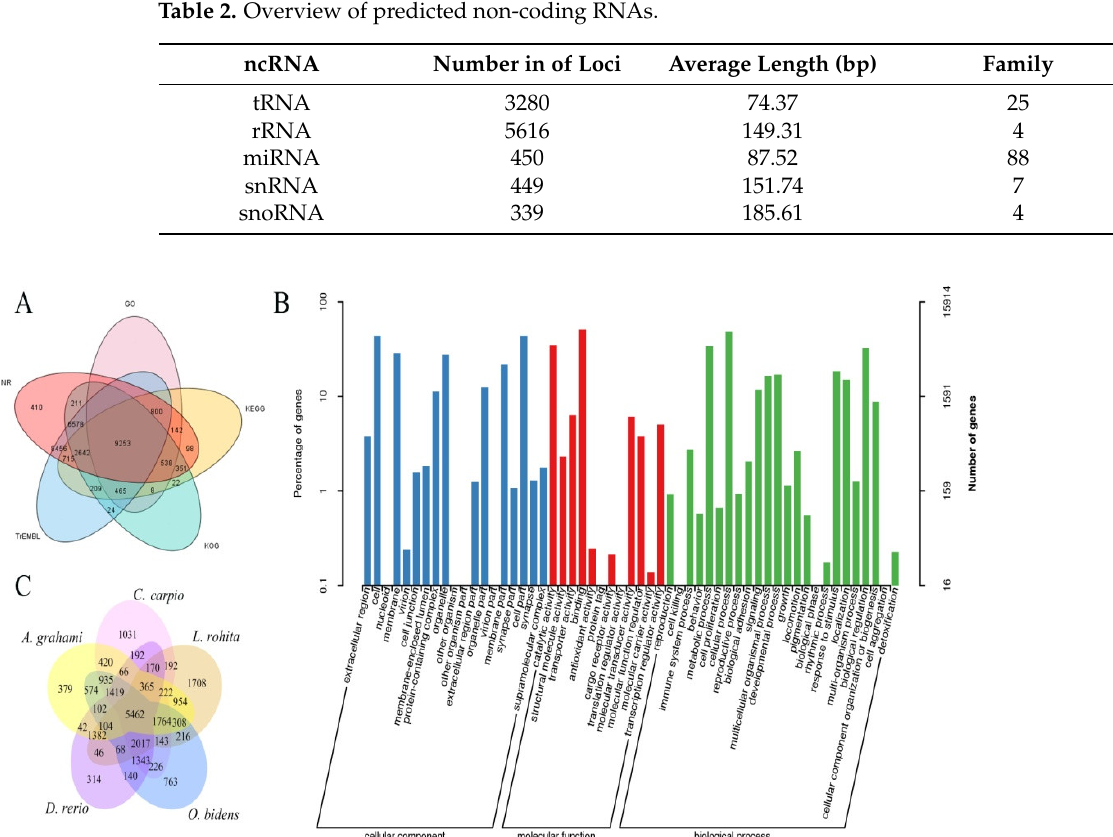
Figure 2. Gene annotation and function of male O. bidens ’ genome. ( A ) Different database-annotated genes. ( B ) Gene functionally classification by GO analysis. ( C ) A Venn diagram showing the number of species-specific and shared gene orthogroups of O. bidens between D. rerio , L. rohita , C. carpio , and A. graham .